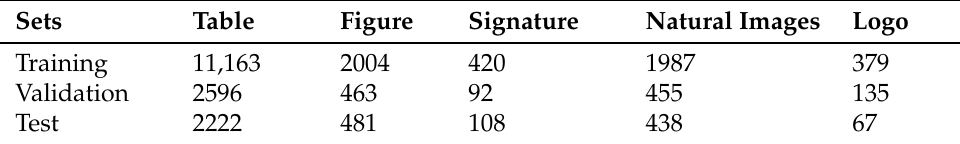
Table 3. Statistics of training, validation, and testing sets in the IIIT-AR-13k [9] dataset. Sets